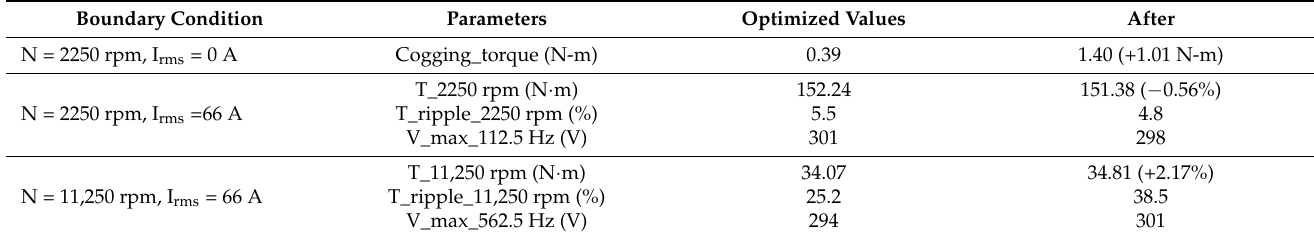
Table 10. Output parameters before and after optimization of rotor auxiliary